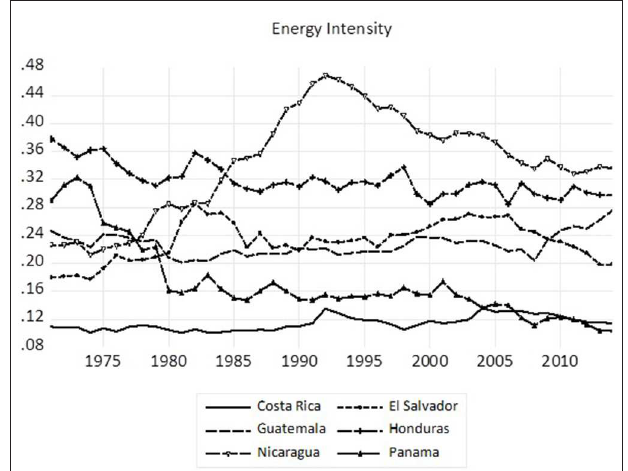
FIGURE 2 | Energy intensity.